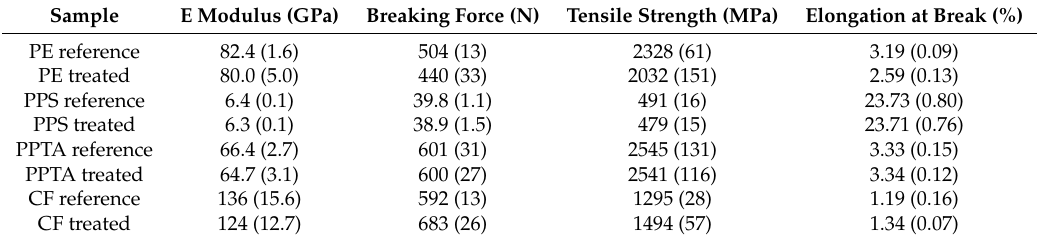
Table 3. Stress-strain behavior of untreated and oxy-fluorinated high-performance fibers (standard deviation in parenthesis). All high-performance fibers were prepared with Recipe 2, except CF (Recipe